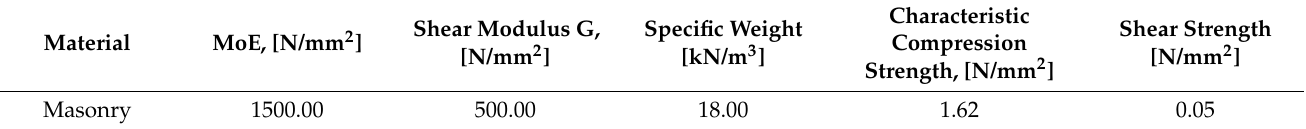
Table 2. Masonry